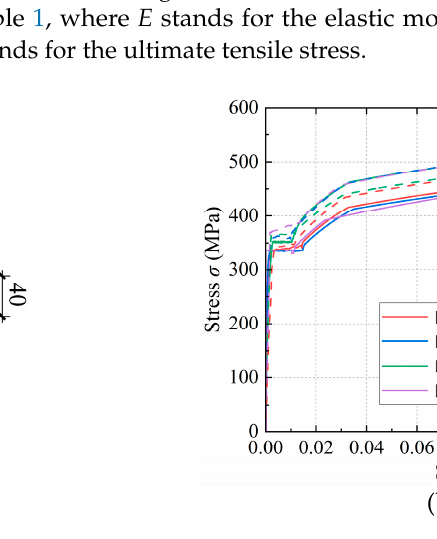
Figure 1. Mechanical testing: ( a ) The size of tension coupon; ( b ) Stress–strain curves.